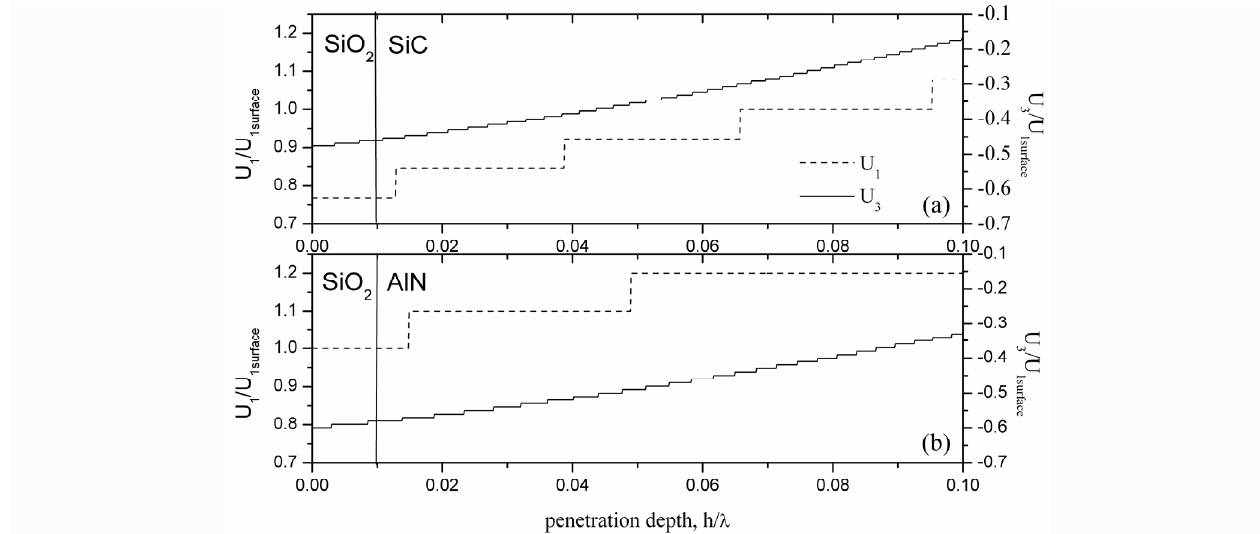
Figure 6. The normalized particle displacement components vs. the penetration depth (calculated by 0.0001 h/ λ steps) along the ( a ) SiO AlN/SiC(001)<110>-SFT